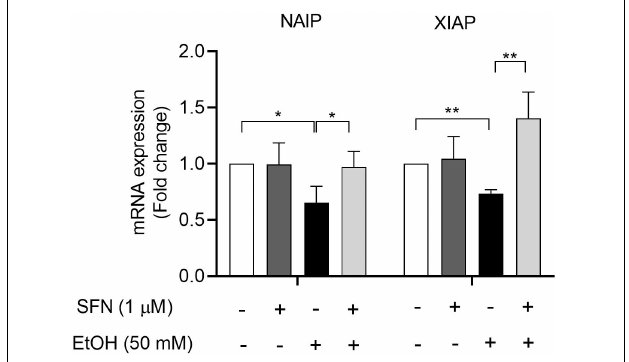
FIGURE 4 | SFN diminished ethanol-induced down-regulation of IAP genes in hNCCs. hNCCs were treated with 1 µ M SFN for 24 h, followed by concurrent exposure to 1 µ M SFN and 50 mM ethanol for an additional 24 h. The mRNA expression of the NAIP and XIAP was determined by using qRT-PCR. The data were expressed as fold change over control and represent the mean ± SEM of three separated experiments. * p < 0.05, ** P <